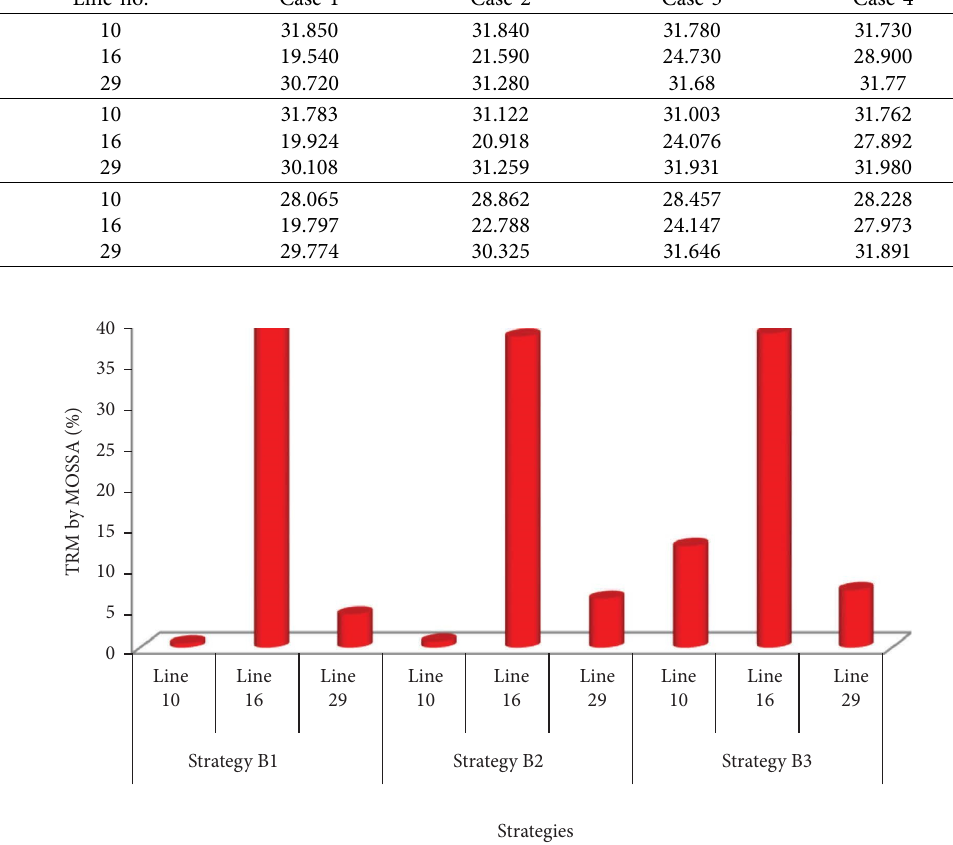
Figure 11: Percentage Improvement in TRM over critical lines for Group